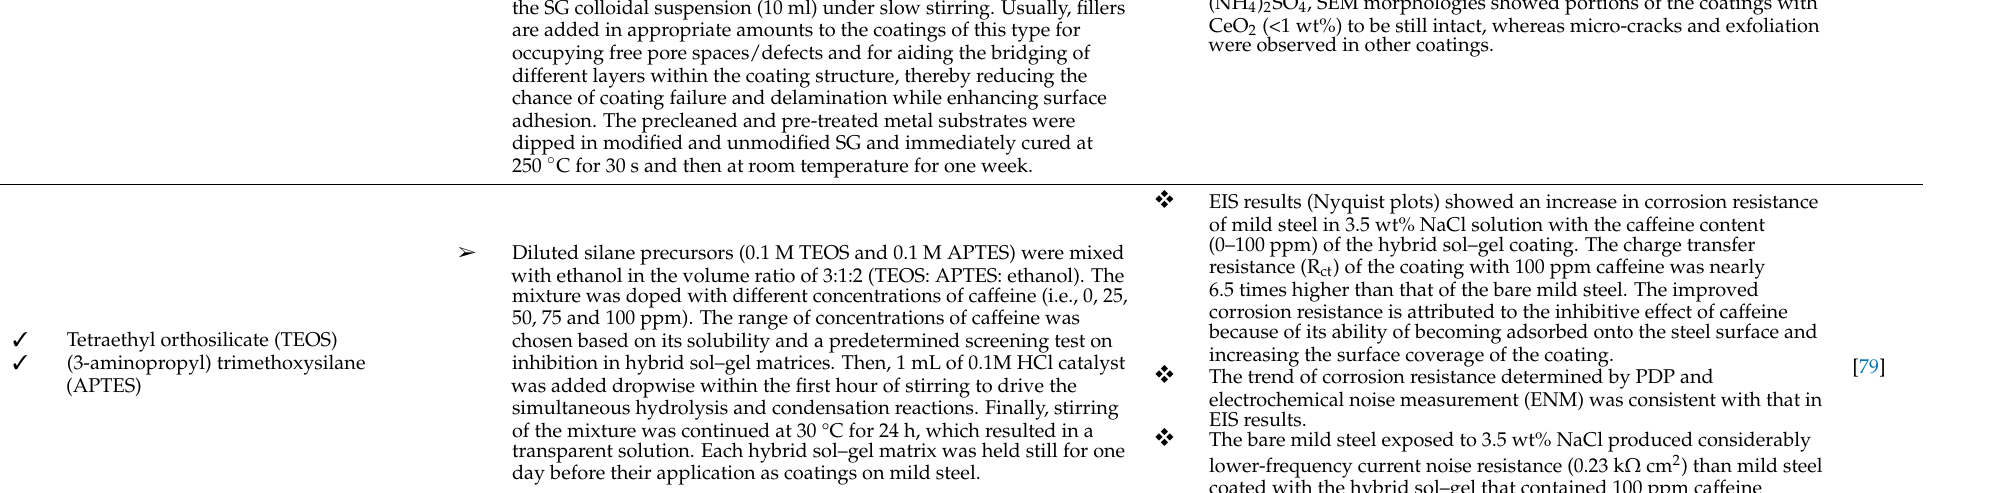
Table 1. Different approaches for improving silane coatings and the main findings, as reported in the literature. Coating Preparation Main Findings